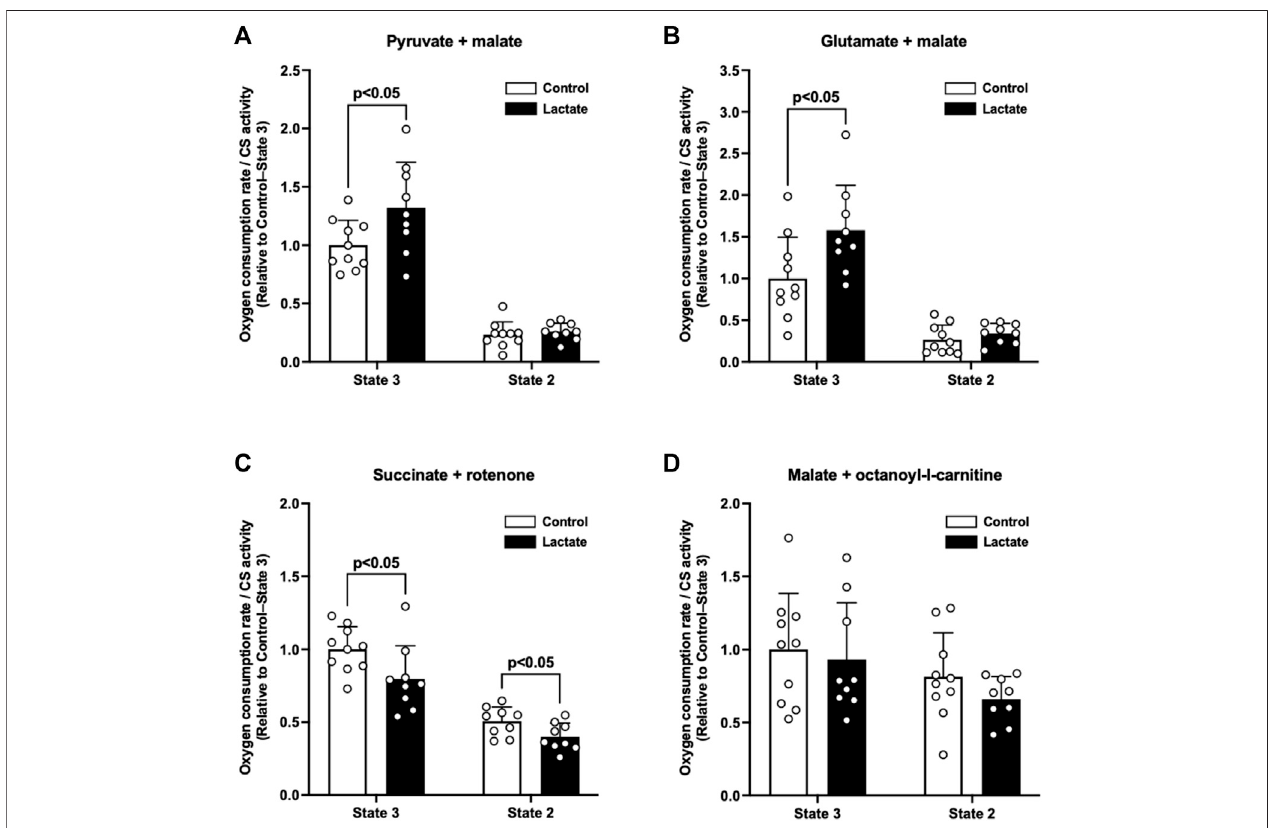
FIGURE 1 | Oxygen consumption rate (OCR) in isolated mitochondria. (A) Pyruvate + malate-induced (complex I-driven) OCR. (B) Glutamate + malate-induced (complexI-driven)OCR. (C) Succinate+rotenone-induced(complexII-driven)OCR. (D) Malate+octanoyl- L -carnitine-induced OCR.Dataareexpressed asmean±SD and are normalized to citrate synthase (CS) activity. Control group: n = 10, Lactate group: n = 9. Unpaired Student ’ s t-test was used for statistical evaluation.